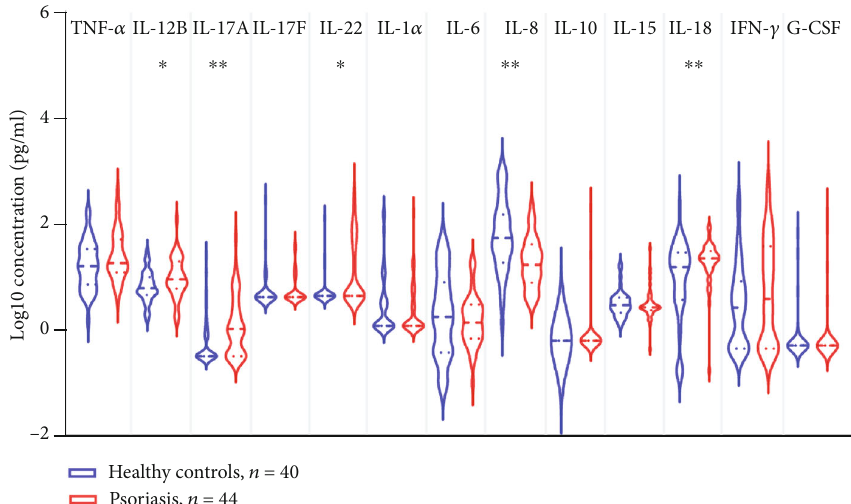
Figure 1: Pro fi le of serum cytokines in healthy controls and psoriasis patients. Serum levels of tumor necrosis factor (TNF- α ), interleukin- (IL-) 12B, IL-17A, IL-17F, IL-22, IL-1 α , IL-6, IL-8, IL-10, IL-15, IL-18, interferon gamma (IFN- γ ), and granulocyte colony-stimulating factor (G-CSF) in healthy controls (HC, n = 40 ) and psoriatic patients (PSO, n = 44 ) are measured by multiplex bead-based technology. Dotted line shows median and quartile. ∗ p < 0 : 05 , ∗∗ p < 0 : 01